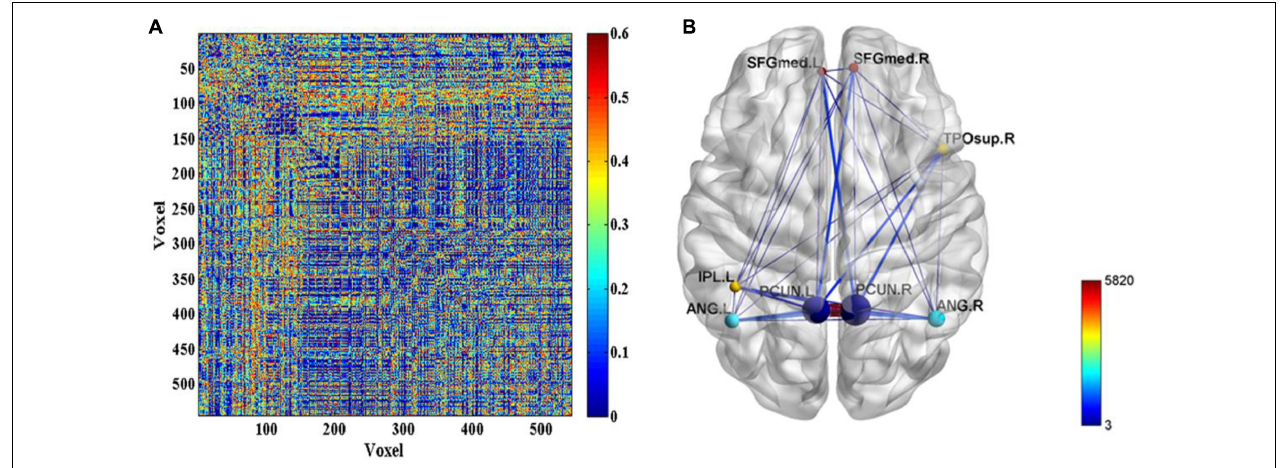
FIGURE 2 | (A) The p -values of t -test on the functional connectivities (FCs) between the common activated voxels of the seafarer and non-seafarer groups. (B) The spatial brain network between Anatomical Automatic Labeling (AAL) regions with activated voxels of FCs with significant differences.